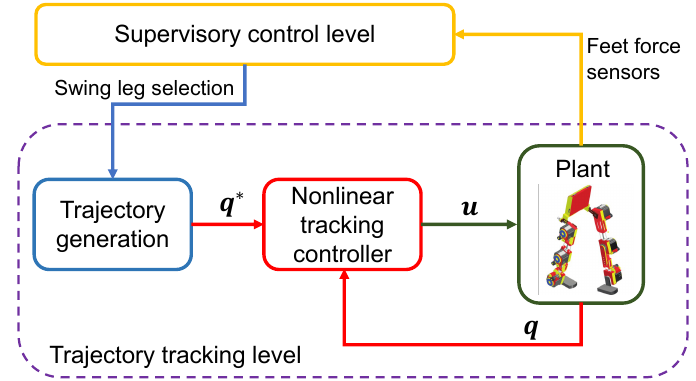
Figure 6. Motion control